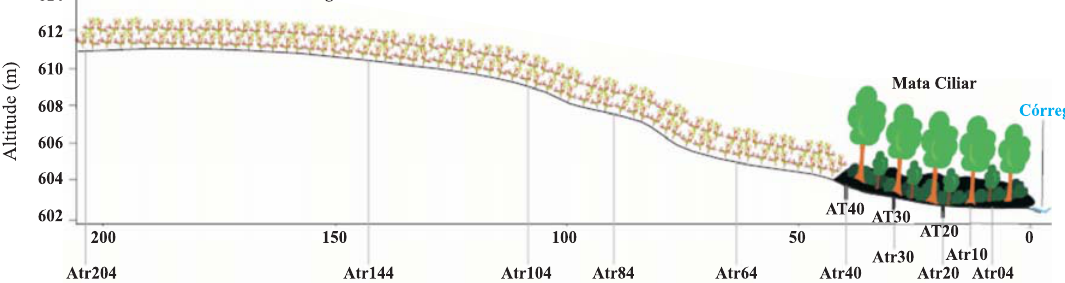
Figura 1. Perfil topográfico da vertente de amostra com a localização das tradagens (Atr) e das trincheiras (AT). Em que AT: trincheira e ATr: tradagens, e o índice numérico indica a distância entre o ponto de amostragem e o curso de